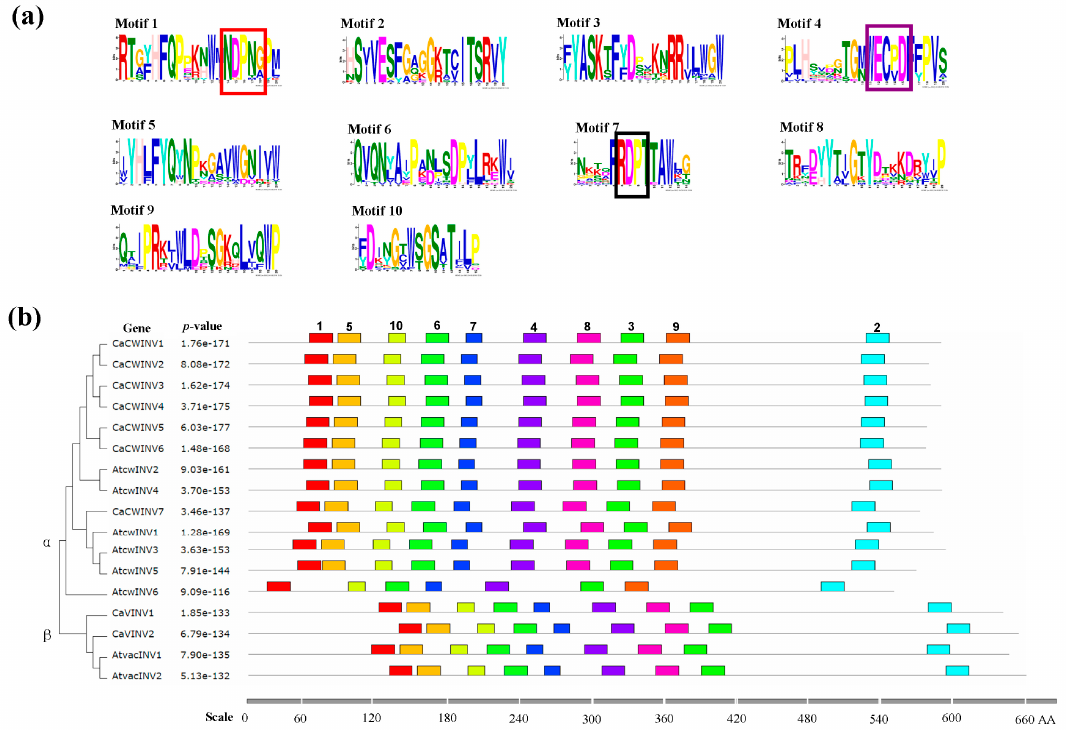
Figure 5. The motifs of AINV proteins from pepper and Arabidopsis according to phylogenetic relationships. ( a ) The ten motif sequences identified by Multiple Em for Motif Elicitation (MEME). The conserved motifs-NDPNG, RDP, and WECP(V)D are depicted by red, black, and purple boxes, respectively. ( b ) Motif distribution in AINVs. The phylogenetic relationship tree of CaAINVs and AtAINVs was constructed using Muscle and MEGA7 software. Gray lines depict non-conserved sequences, and each motif is depicted by a colored box. The length of the motifs in each protein is shown proportionally.